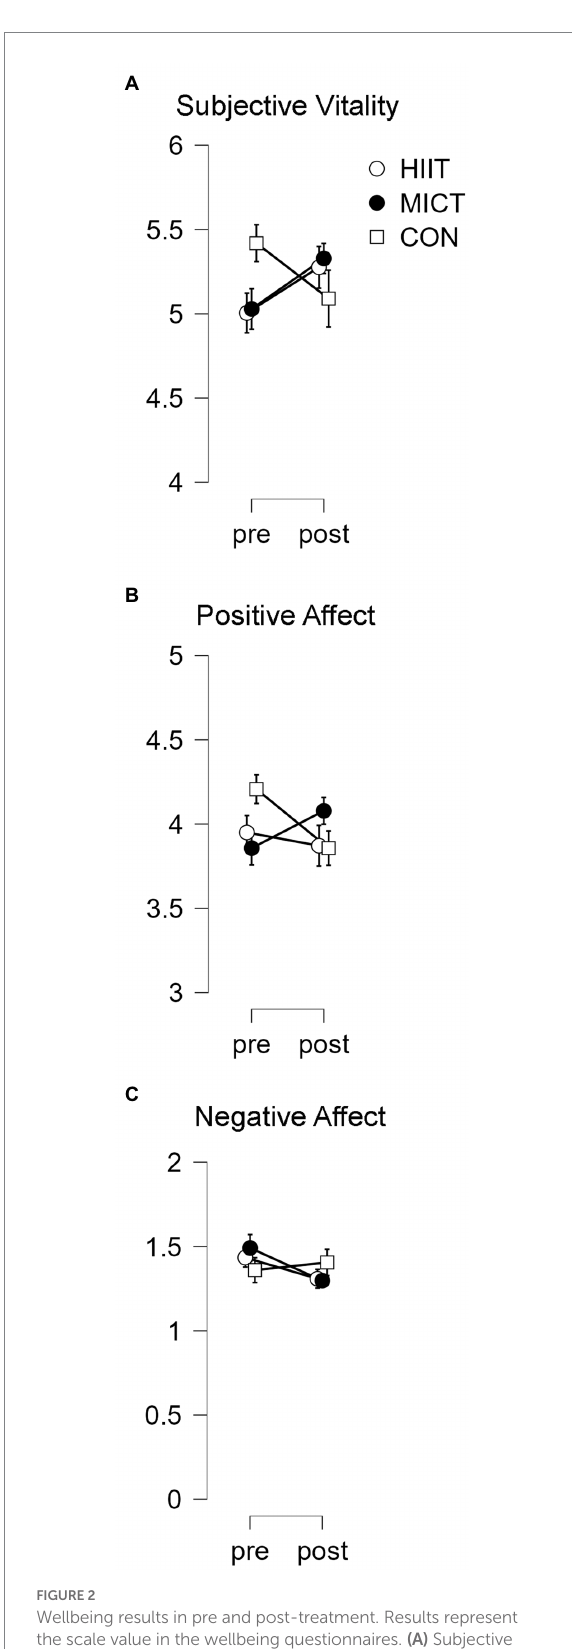
FIGURE 2 Wellbeing results in pre and post-treatment. Results represent the scale value in the wellbeing questionnaires. (A) Subjective vitality results. (B) Positive affect results. (C) Negative affect